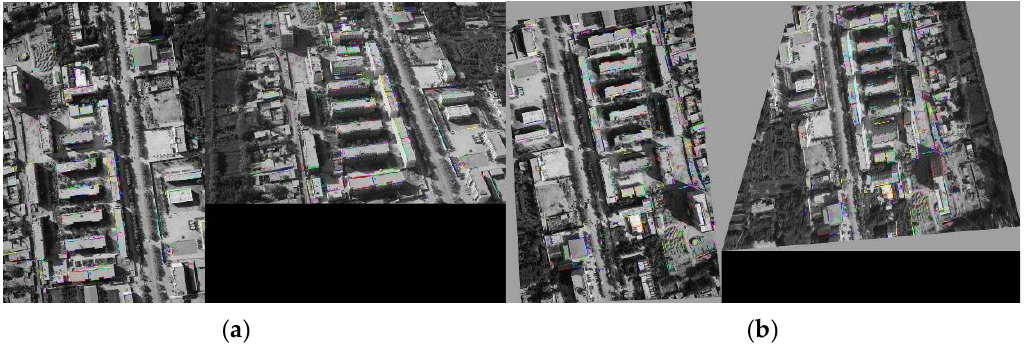
Figure 10. Comparison of the line matching results of the first image pair between original images and rectified images: ( a ) original images, 117/186/62.9%; ( b ) rectified images, 238/301/79.1%.